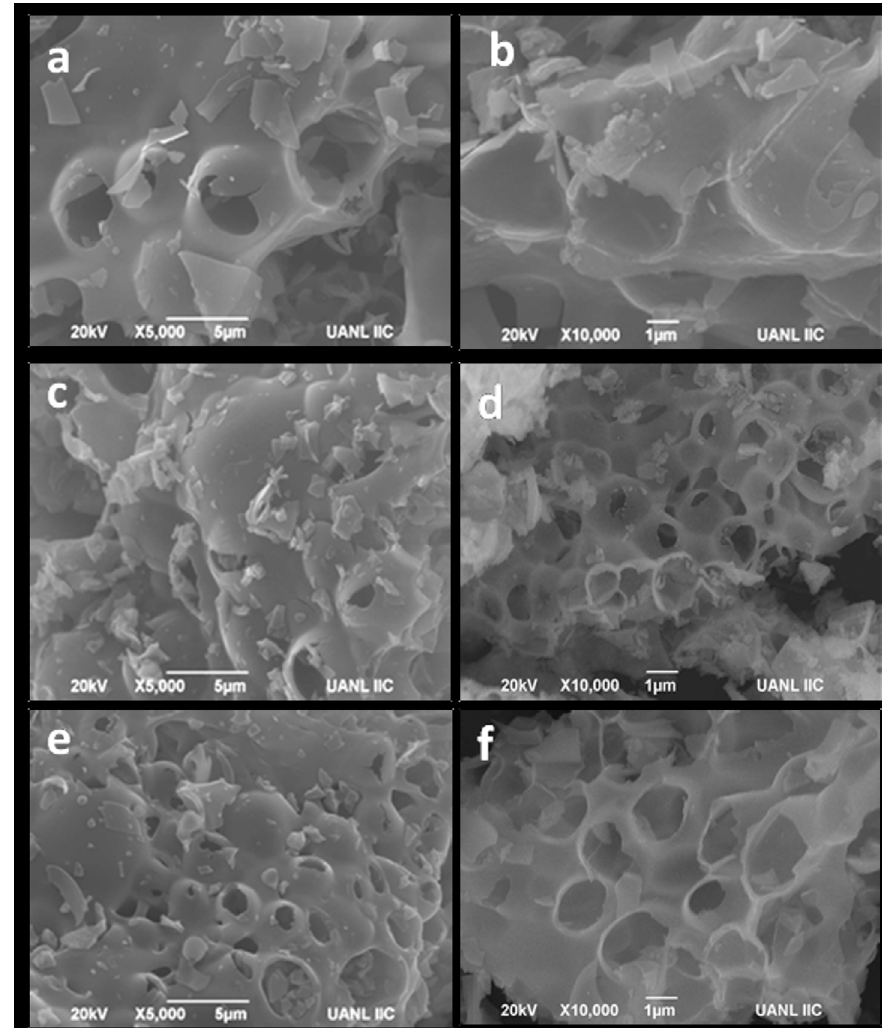
, (c,d) CoTiO and (e,f) NiTiO calcined at 700ºC / 10h , 700ºC/2h 3 3 3